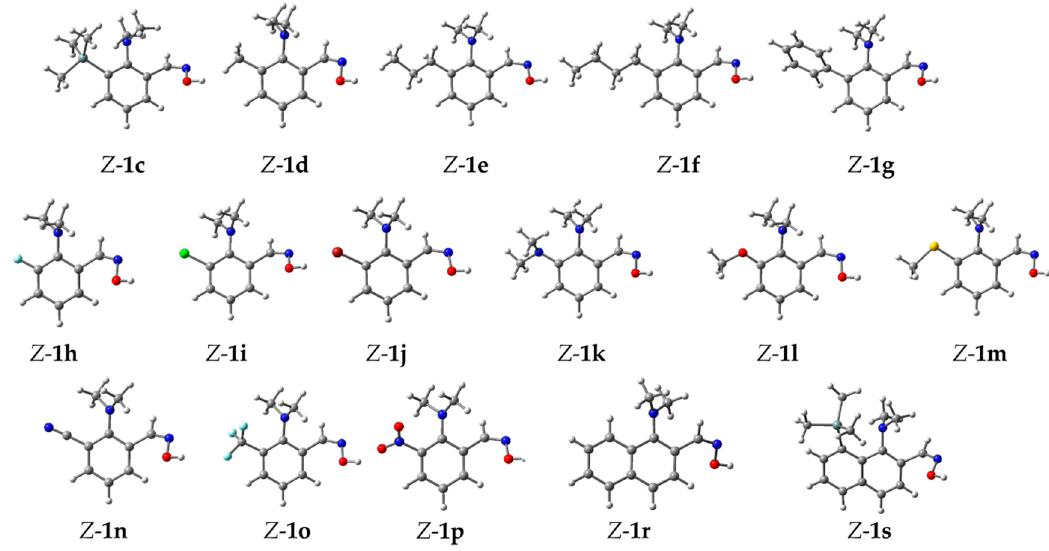
Figure 6. Optimized geometries of Z -aldoximes 1c – 1s .